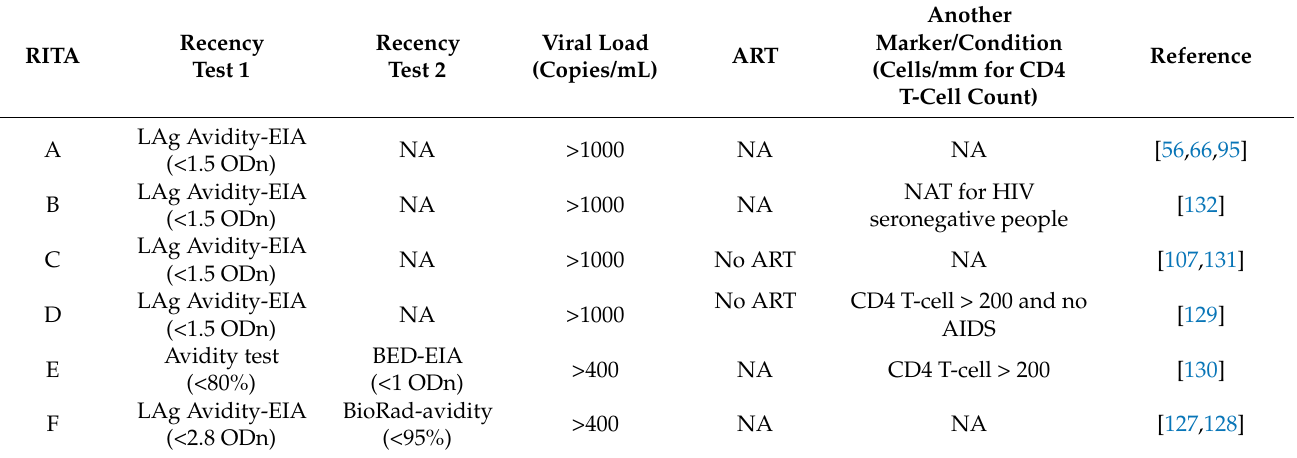
Table 2. Examples of testing algorithms for recent HIV infection (criteria for recency) that have been used in various